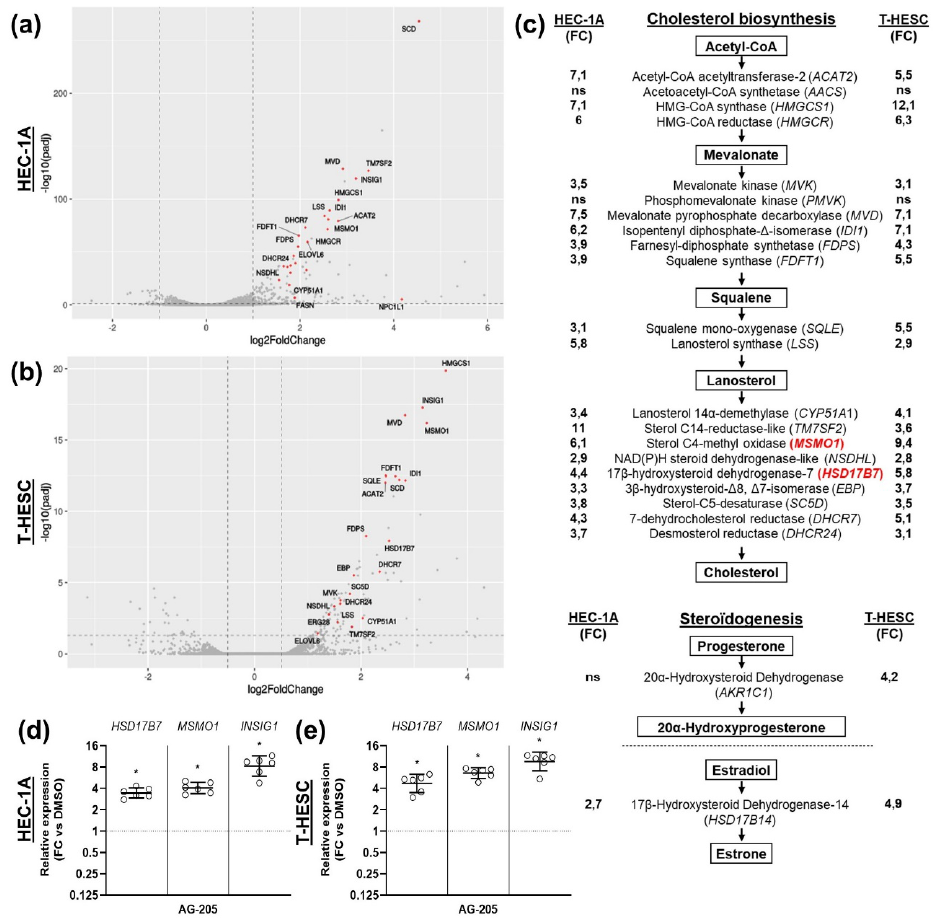
Figure 2. AG-205 increases RNA concentration of enzymes involved in sterol biosynthesis. RNA sequencing was used to compare transcriptomes of HEC-1A ( a , c ) or T-HESC cells ( b , c ) incubated for 32 h with 15µM AG-205 or control DMSO. ( a , b ) Volcano plots for HEC-1A ( a ) and T-HESC ( b ) cells were generated with Over Representation Analysis (ORA). Genes from the first GO term (GO:0016126) differentially expressed upon AG-205 addition (adjusted p value < 0.05 and a |log2 fold change| > 1) are represented by red dots. Only Top30 genes are labelled. ( c ) Synthetic representation of enzymes involved in cholesterol biosynthesis and steroidogenesis. Significant expression increases measured upon AG-205 addition by comparison with corresponding DMSO control are indicated as fold changes (FC) at left for HEC-1A and at right for T-HESC cells. ( d , e ) Relative expression of HSD17B7 , MSMO1 and INSIG1 was measured by RT-qPCR in other cell samples, normalized, compared to corresponding control DMSO values, and is presented as individual fold changes (FC) in log2 scale and as geometric means with geometric SD ( n = 6). Statistical test: Wilcoxon paired test, not significant (ns), * p < 0.05.